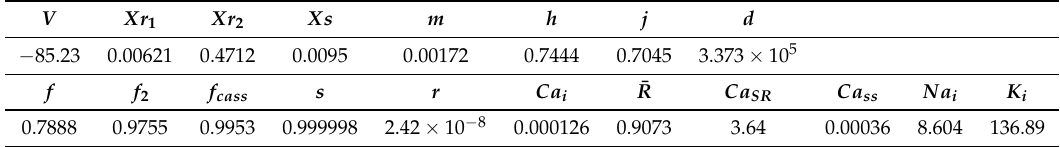
Table A2. Initial conditions used for the TP06 model.